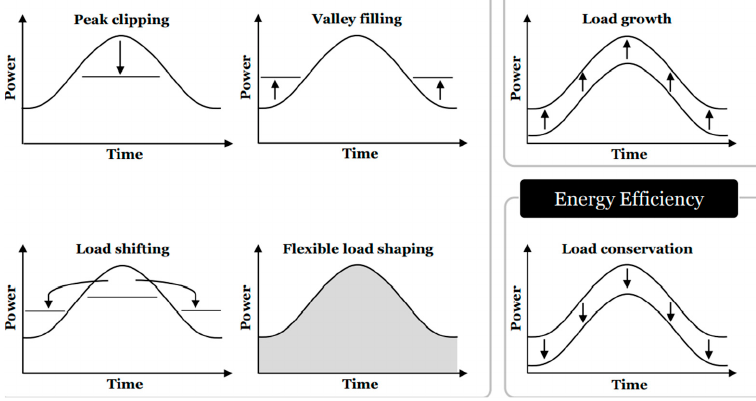
Figure 1. Different demand-side management (DSM) techniques adapted from [28]